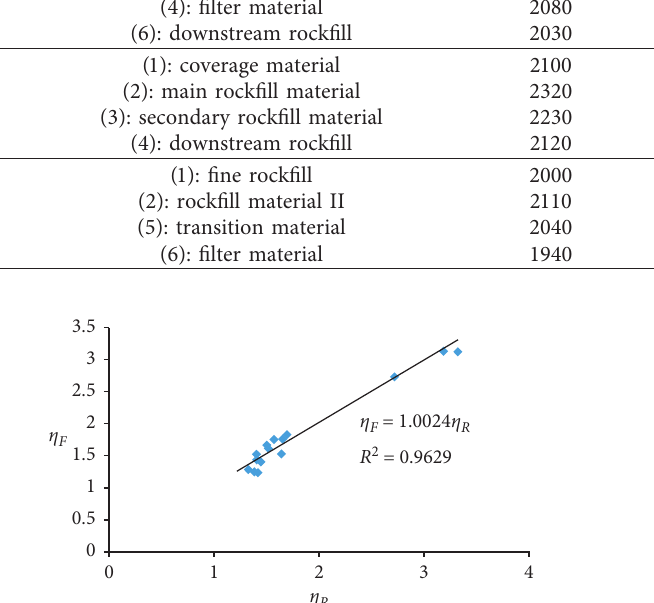
− η R F of the slope of the Nuozhadu hydropower station.